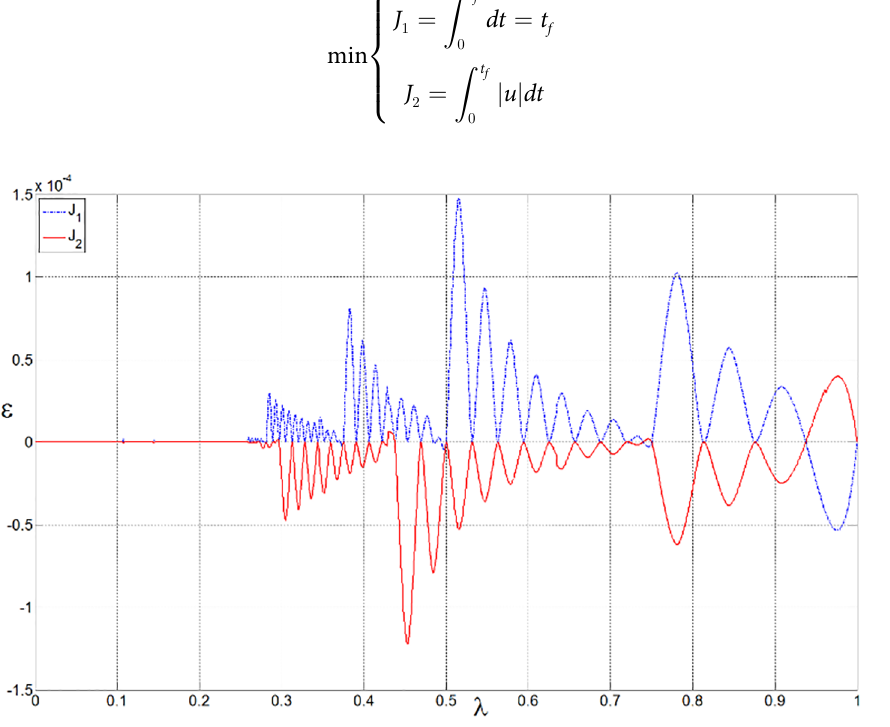
Fig 7. Approximation